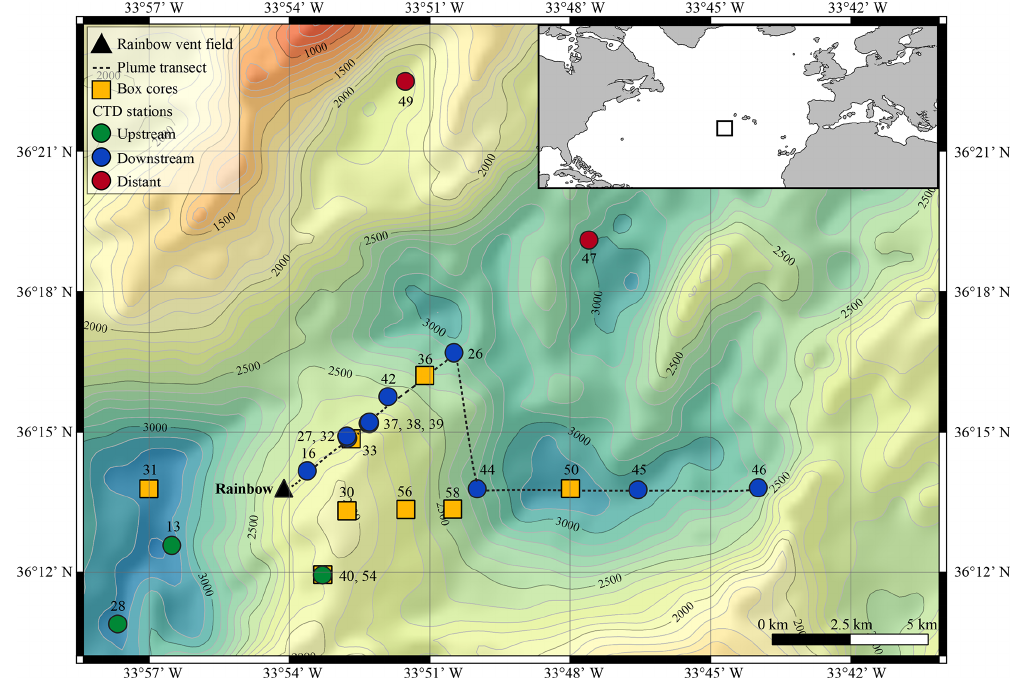
Figure 1. Geographical location (inset) and bathymetric map of the Rainbow study site on the Mid-Atlantic Ridge (from the European Marine Observations and Data Network, EMOD, database), with sampling locations